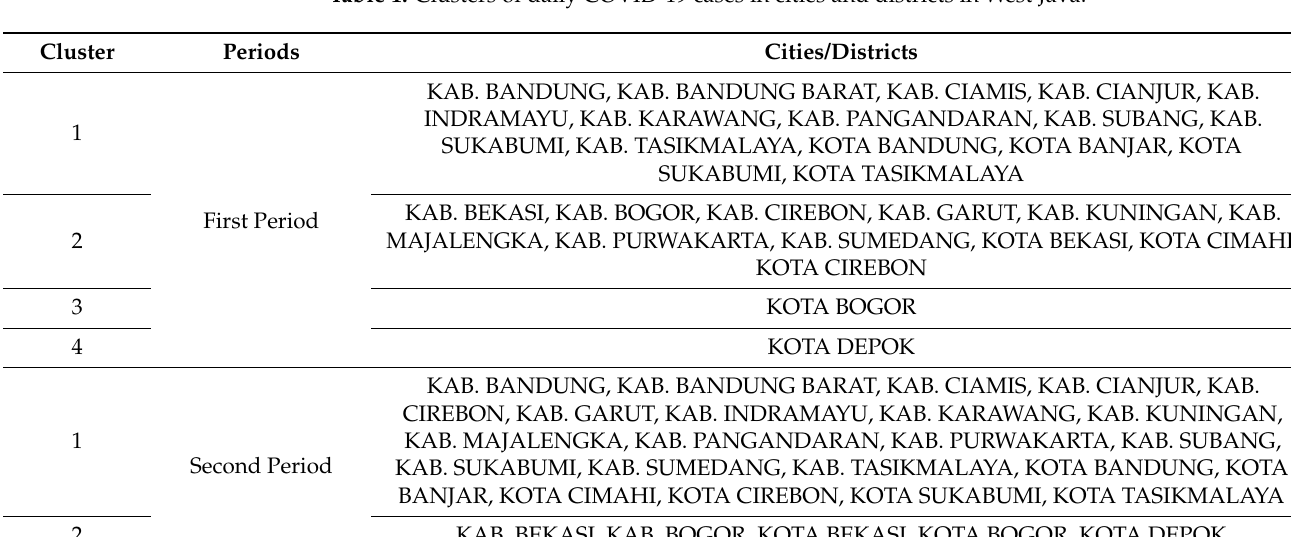
Figure 2. The optimal number of clusters based on the elbow method: ( a ) Clustering period 1 July 2021–30 September 2021, ( b ) clustering period 1 January 2022–31 May 2022. Table 1. Clusters of daily COVID-19 cases in cities and districts in West Java.